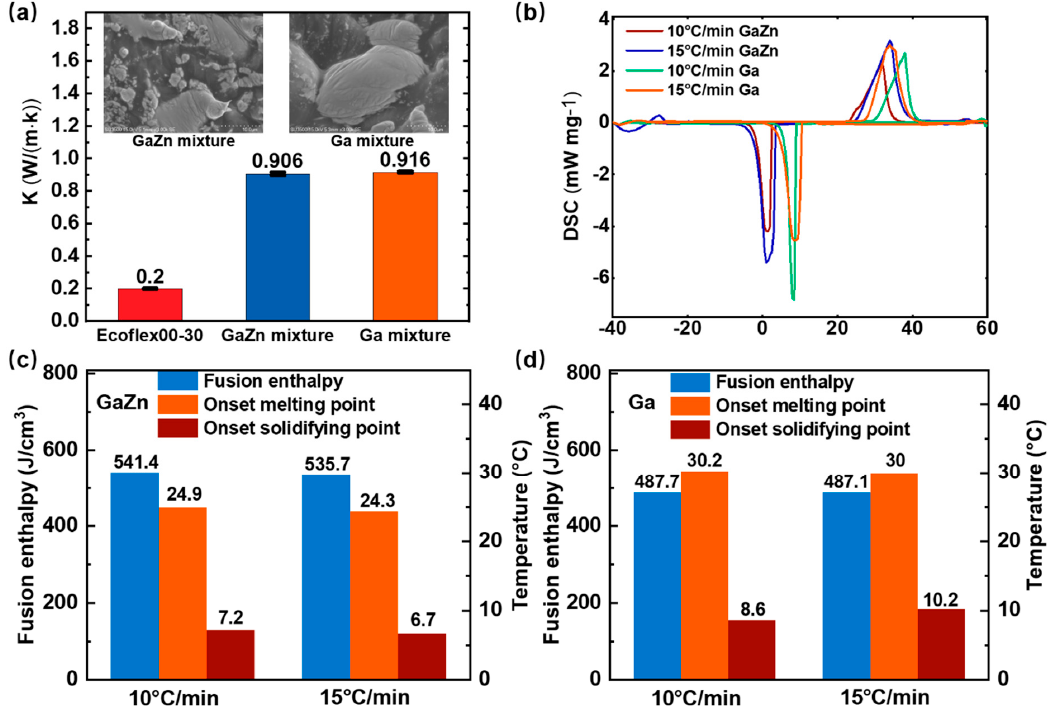
Figure 2. Thermal properties of the LM and its elastic composites LM-WTEG: ( a ) the thermal con- ductivities of the Ga/GaZn and the mixtures; ( b ) DSC curves of Ga/GaZn; phase change properties of ( c ) GaZn and ( d ) Ga.